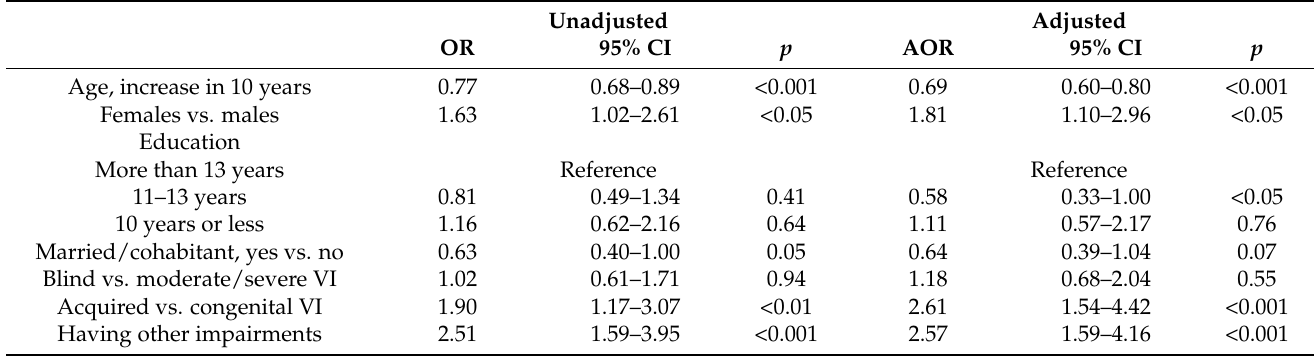
Table 3. Factors associated with current PTSD in the VI sample ( n = 736), unadjusted and adjusted analyses. Unadjusted Adjusted OR 95% CI p AOR 95%